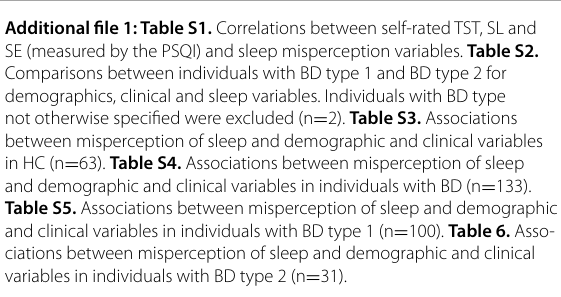
Table S5. Associations between misperception of sleep and demographic and clinical variables in individuals with BD type 1 (n 100). Table 6. Asso‑ = ciations between misperception of sleep and demographic and clinical variables in individuals with BD type 2 (n 31). = Abbreviations BD: Bipolar disorder; BMI: Body mass index; DIGS: Diagnostic interview for genetic studies; HC: Healthy controls; MADRS: Montgomery and asberg depression rating scale; OSA: Obstructive sleep apnea; PSQI: Pittsburgh sleep quality index; SE: Sleep efficiency; SL: Sleep latency; TST: Total sleep time; YMRS: Young’s mania rating